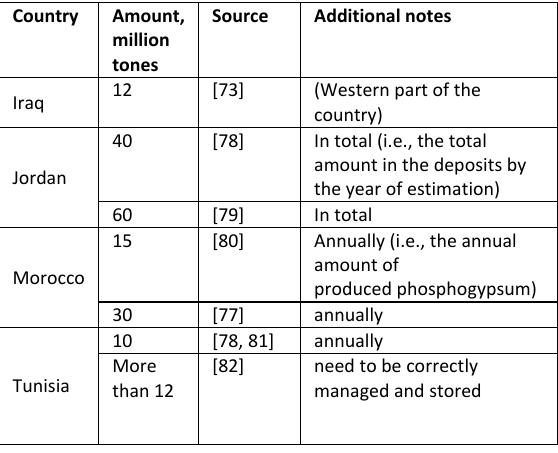
Table 1. The amount of phosphogypsum generated in the region by country (based on aggregated data).